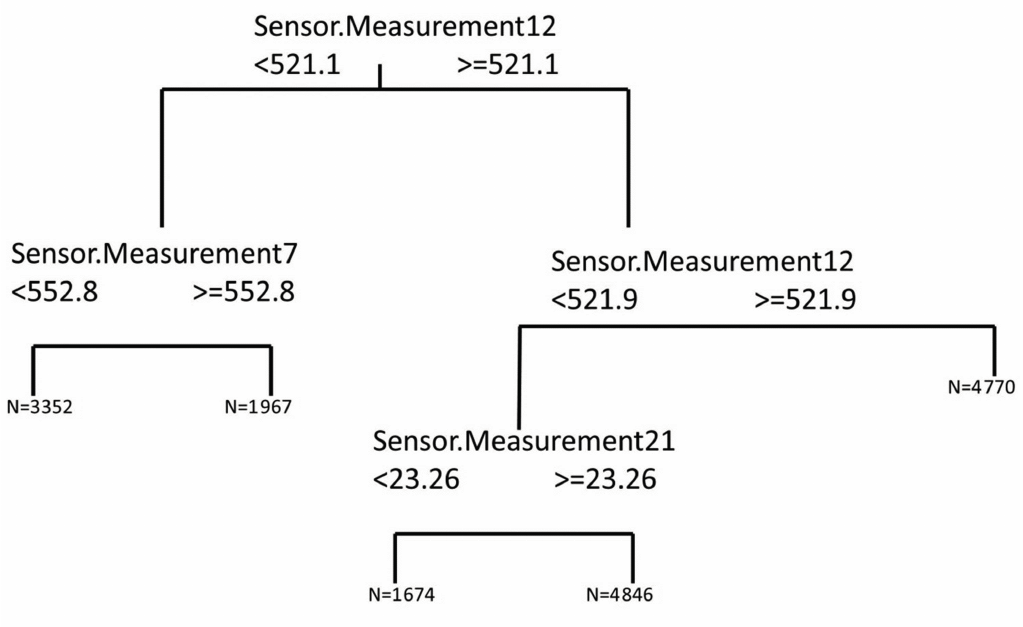
Figure 4. Regression tree of the remaining useful life variable using as input variables Sensor.Measurement7, Sensor.Measurement12, Sensor.Measurement20 and